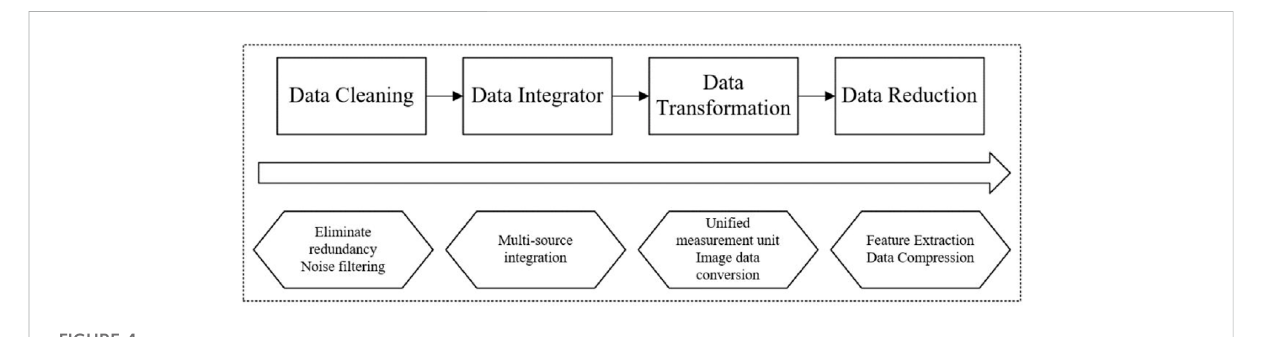
FIGURE 4 The work fl ow for pre-processing multi-source heterogeneous